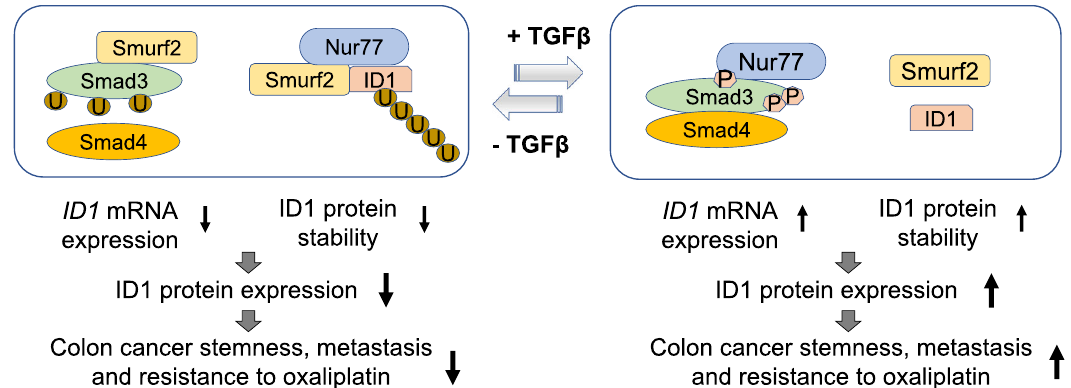
Fig. 9 A working model. The crosstalk of Nur77 and TGF β on dual regulations of ID1 expression and the implications in colon cancer progression and oxaliplatin resistance. U ubiquitin, P